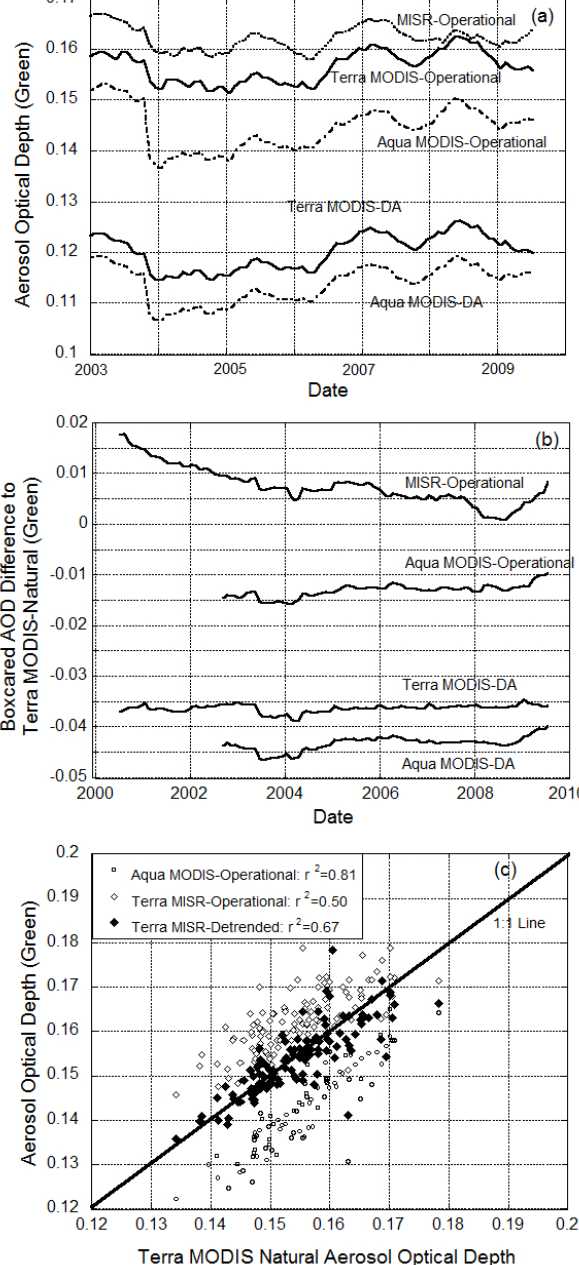
Fig. 3. (a) Boxcar analysis (2003-2009) for the monthly mean Terra MISR, Terra MODIS (operational), Aqua MODIS (operational), the DA quality Terra MODIS, and the DA quality Aqua MODIS over water aerosol products for global oceans. The boxcar window size is set to ± 5 months. (b). The boxcared AOD differences for the boxcar analyses from (a) to the boxcar analysis from the original Terra MODIS AOD data. (c). The scatter plot of the boxcared AOD data from the original Terra MODIS to the original Aqua (open square), the MISR (open diamond) AOD data, and the de-trended MISR (filled diamond) AOD